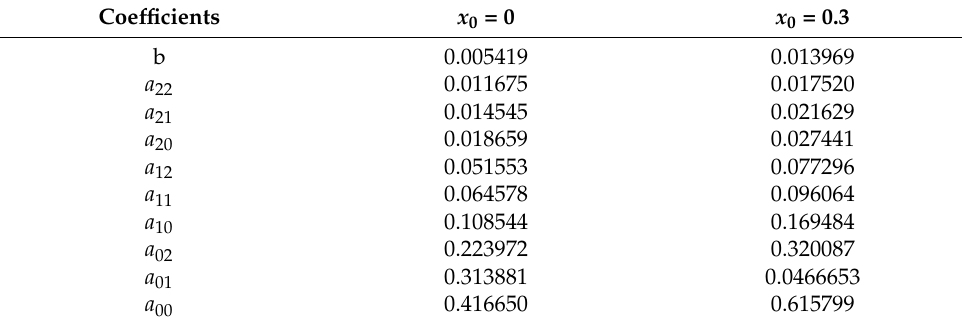
Table 5. The values of the coefficients in Equation